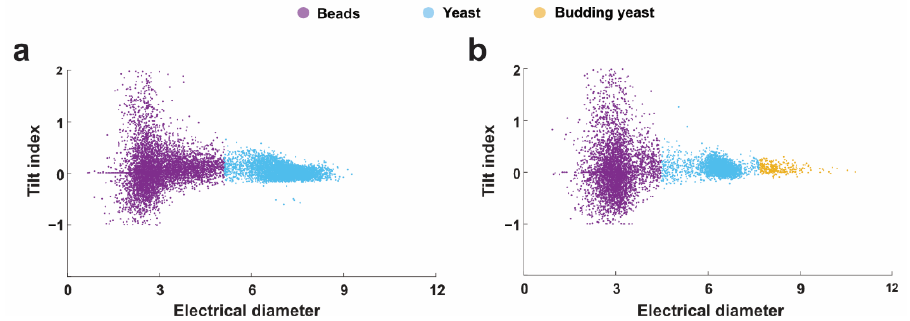
Figure 5. Scatter plot (electrical diameter vs. tilt index) of single cell detection; ( a ) signals from electrodes with 5 µm gap scatters; ( b ) signals from electrodes with 5 µm gap scatters.